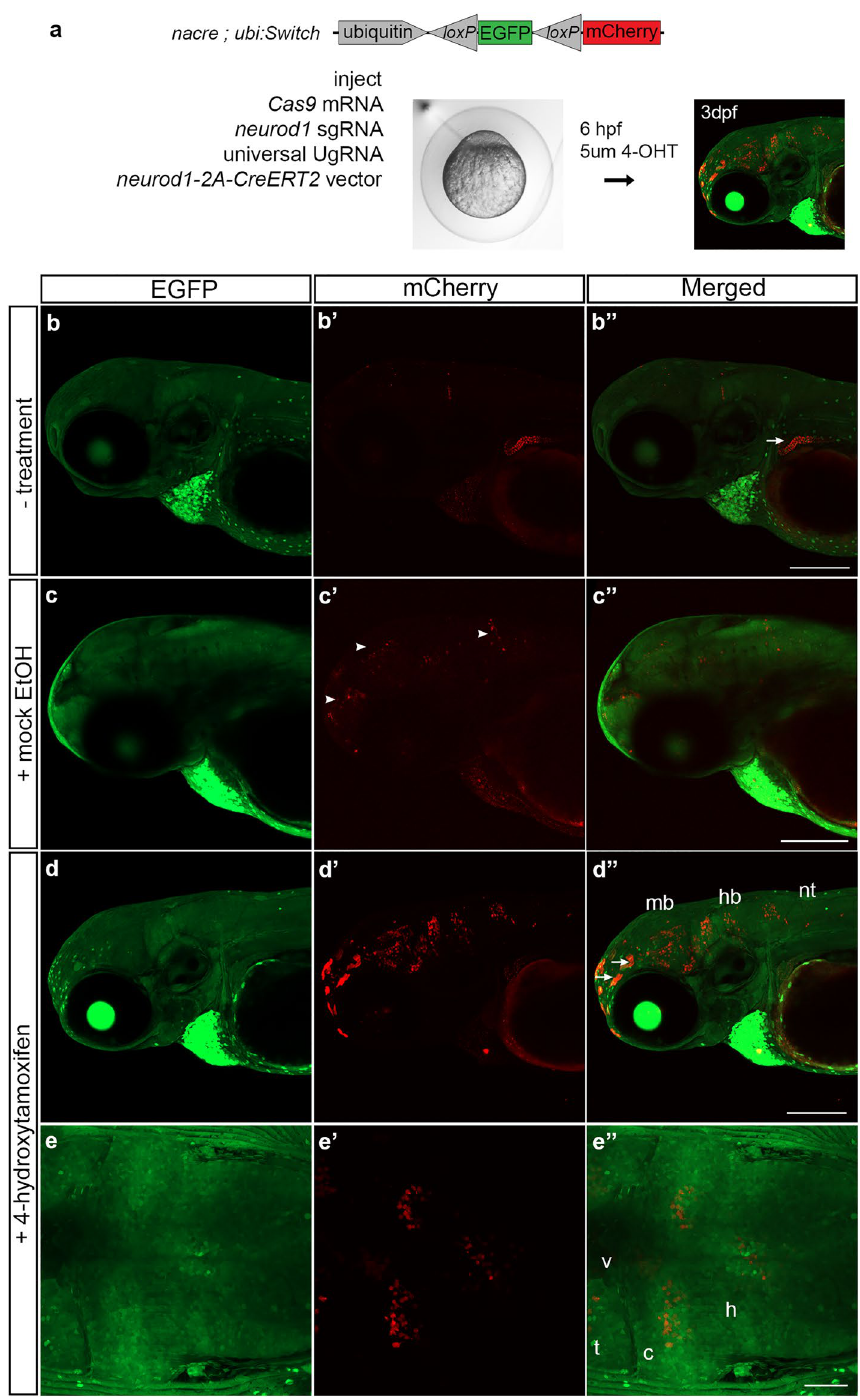
Figure 5. Tamoxifen regulated CreERT2 recombinase activity in F0 somatic targeted embryos. ( a ) nacre; ubi:Switch embryos injected with Cas9mRNA, sgRNAs and the neurod1-2A-CreERT2 targeting vector. At 6 hpf embryos were mock treated or treated with 5um 4-hydroxytamoxifen and imaged at 3 dpf. ( b – b ′′ ) Injected embryos without treatment or ( c – c ′′ ) mock treated show a low level of expression in the brain. ( d – d ′′ ) 4-hydroxytamoxifen treatment resulted in switching from EGFP to mCherry expression in cells in the midbrain, hindbrain and neural tube. Arrows point to off-target expression. ( e – e ′′ ) Dorsal imaging of the brain in the larvae shown in d – d ′′ revealed mCherry expression was detected in cells throughout the midbrain and hindbrain parenchymal tissue. 4-OHT 4-hydroxytamoxifen, c cerebellum, EGFP enhanced green fluorescent protein, hb hindbrain, mb midbrain, nt neural tube, t optic tectum, v ventricle. Scale bars ( b ′′ , c ′′ , d ′′ ) 200 μm; ( e ′′ ) 50